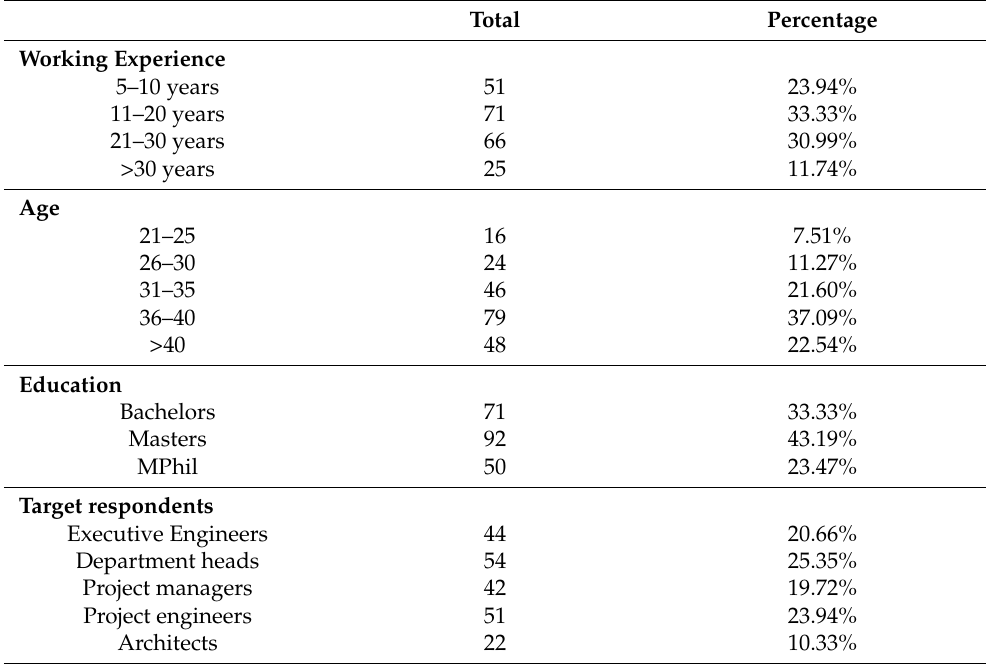
Table 2. Characteristics of the study